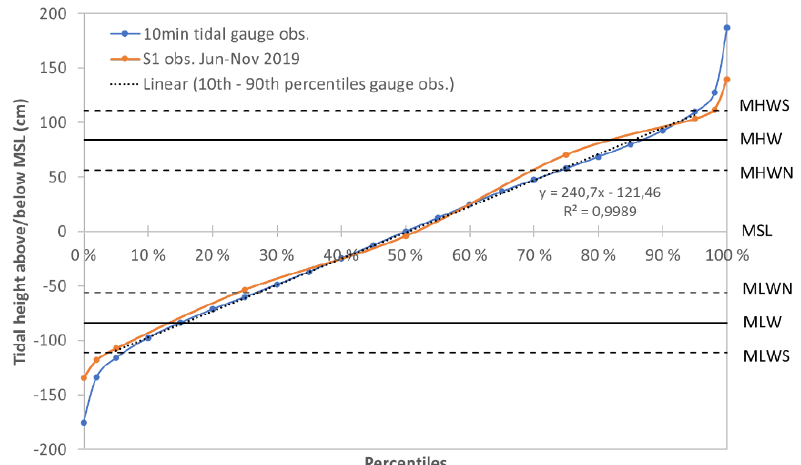
Figure 6. Tidal height percentiles from 2019 tidal gauge measurements at 10 min sampling interval (blue line) and from S1 acquisition times during the 6 month period (June–November 2019) at Hansjordnesbukta (Tidal data ©Kartverket [12]).